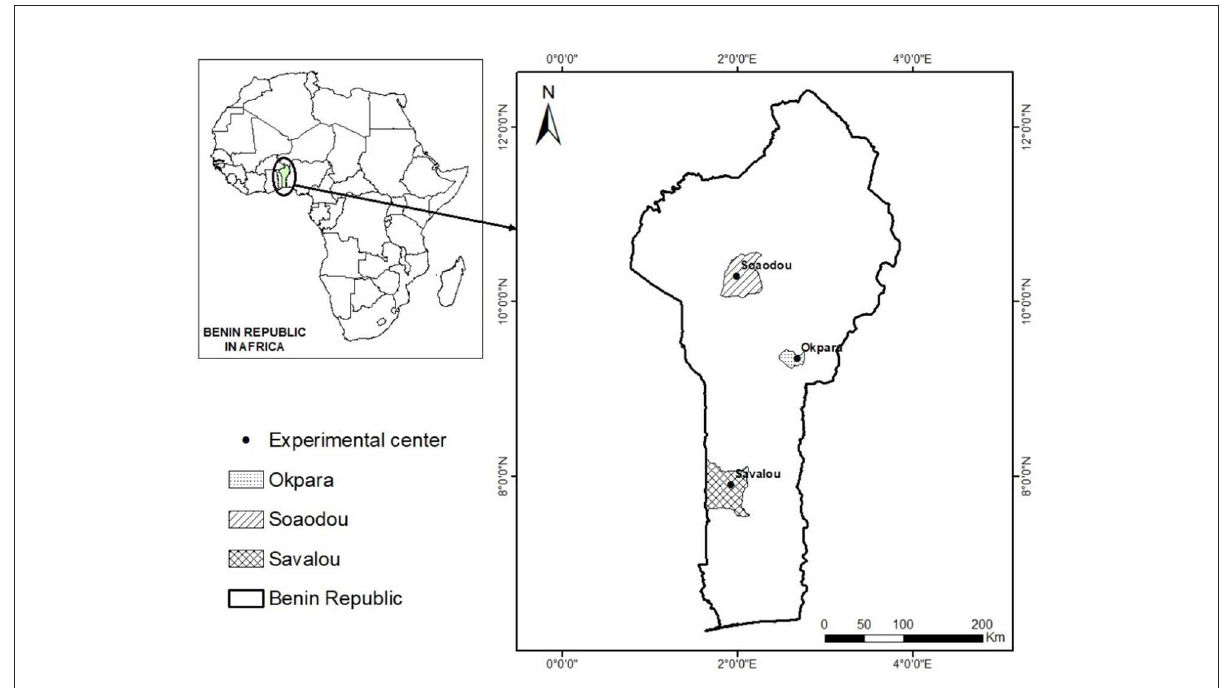
FIGURE1 Experimental centers location at Benin